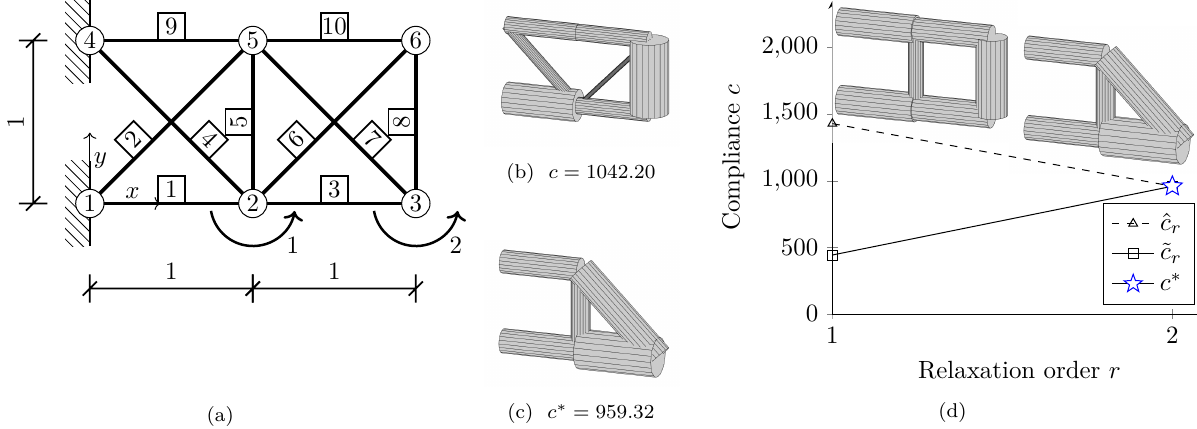
Figure 2. 10-beam structure design problem. (a) shows the design domain. While all the tested local optimization algorithms converged to the topology in (b), the global optimum design (c) obtained by PO possesses a clearly different topology. Figure (d) shows the convergence of PO.